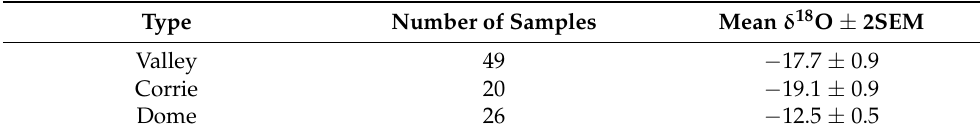
Figure 2. Box plots for δ 18 O in glacier ice of valley (1), corrie (2) glaciers and glacier dome (3) at Mongun-Taiga massif . Table 1. Mean δ 18 O values for different types of glaciers at Mongun-Taiga massif. Table 1. Mean δ 18 O values for different types of glaciers at Mongun-Taiga